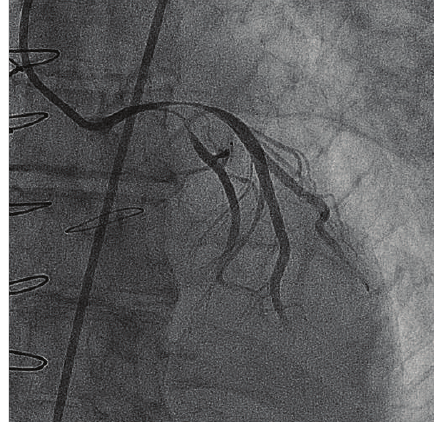
Figure 3: Left coronary artery in RAO caudal projection showing the severe luminal narrowing of the distal LMCA and proximal portions of the LAD and LCx arteries. RAO, right anterior oblique; LMCA, left main coronary artery; LAD, left anterior descending; LCx, left circumflex.